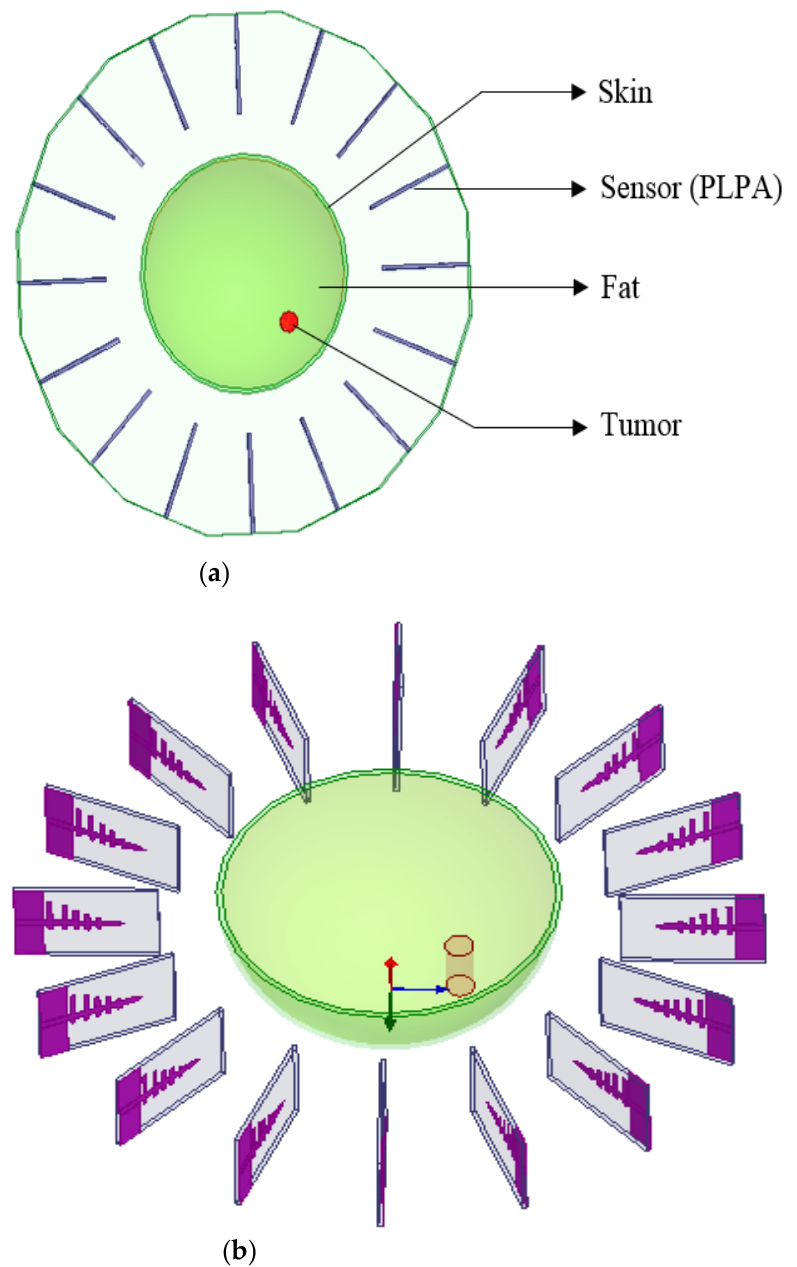
Figure 9. Microwave Imaging System ( a ) Top view and ( b ) Slant view.